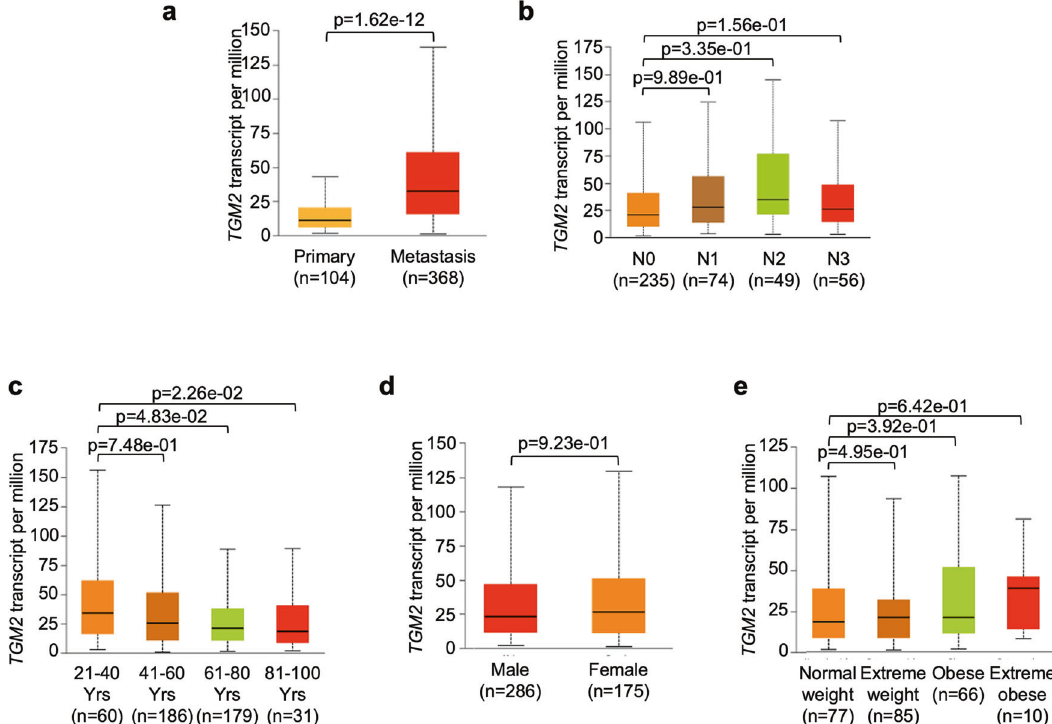
Fig. 3 Clinical characterization and prognostic value of TGM2. Boxplots represent the relationship between TGM2 mRNA expression with the absence or presence of tumor metastasis ( a ), nodal metastasis formation from stage N0 to N3 ( b ), age ( c ), sex ( d ), and body mass index (BMI) ( e ) in patients affected by SKCM using the TCGA database on UALCAN. Data were normalized as transcripts per kilobase million (TPM) values. Data were shown as the mean ± standard deviation. Statistical analyses were performed using t-test. Error bars represented SD. p - values were indicated,